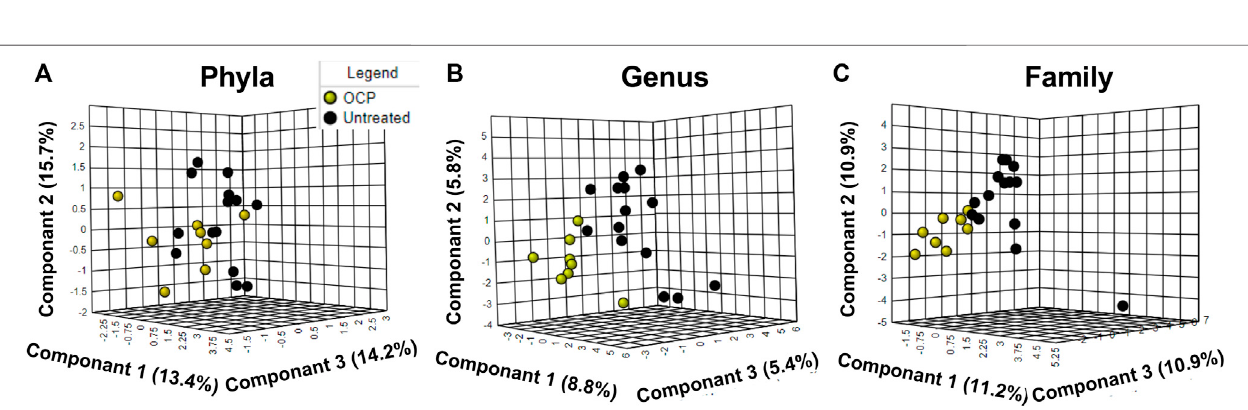
FIGURE2|(A) Phyla; (B) Genus; (C) FamilyMicrobiomedifferencesbetweenOCPanduntreated.PartialLeastSquare-DiscriminantAnalysis(PLS-DA)ofbacterial % relative abundance between groups at the (A) Phyla (B) Genus and (C) Familylevel. Only taxa with > 1%RA areincluded. ForPhyla, principlecomponent2explained 15.7% of the total variance; for genus, Principle component 1 explained 8.8% of total variance; for family, Principle Component 1 explained 11.2% of the variance. Girls with obesity and PCOS with (N = 8) and without (N = 14) oral contraceptive treatment were